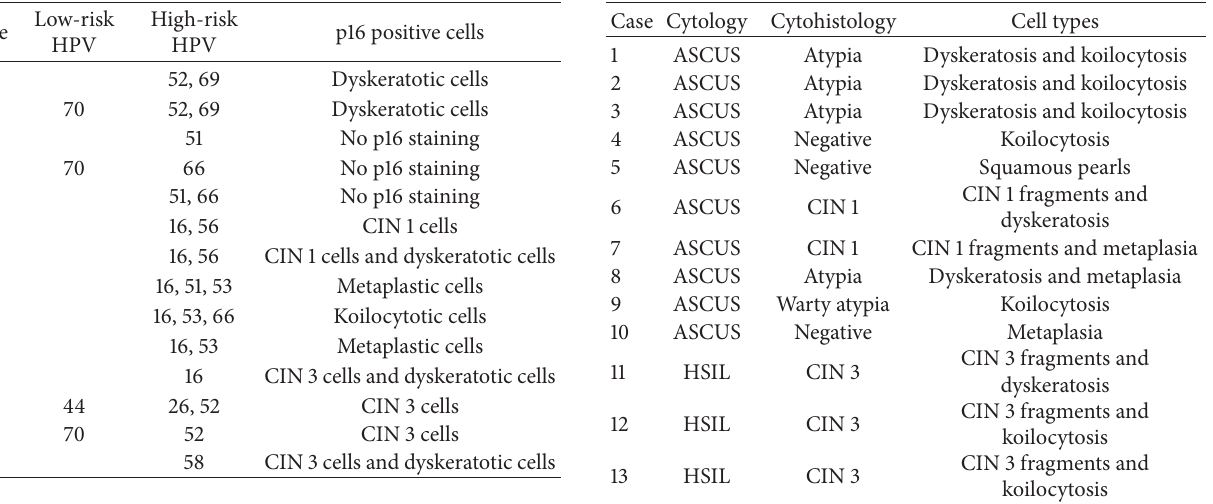
Table 1: Low-risk and high-risk HPV genotypes and biomarker p16 staining.